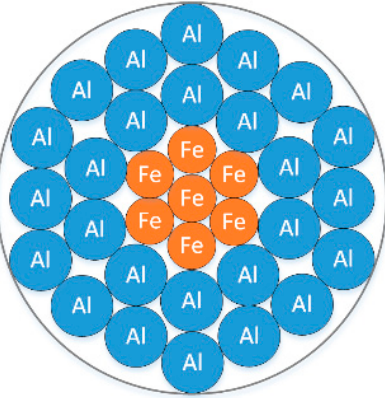
Figure 4. AlFe 240/40 conductor outline.